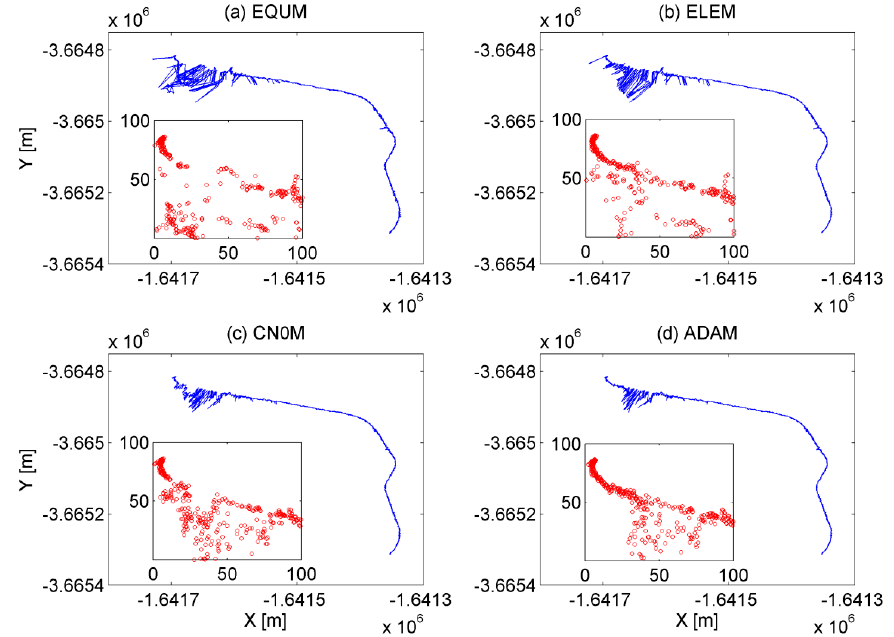
Figure 17. RTD results (blue lines) of dataset no. 3, where the horizontal and vertical coordinates denote the X and Y directions in WGS84 coordinate system respectively, and the detailed results (red points) in meter when the test receiver is located between EEEL and ES buildings. ( a ) Results of the equal-weight model (EQUM); ( b ) results of the elevation model (ELEM); ( c ) results of the C/N0 model (CN0M); and ( d ) results of the adaptive model (ADAM).